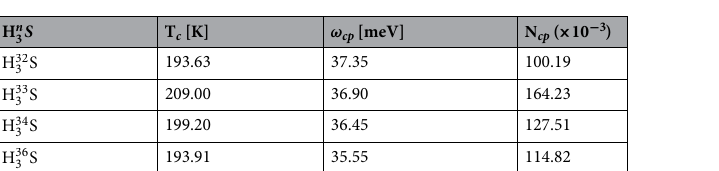
Table 3. Comparison between theoretical T c values reported by Szczesniak 13 , and ω cp and N cp values obtained from D cp (ω , T c ) functions calculated for H 32 3 S , H 33 3 S , H 34 3 S and H 36 3 S at 180 GPa.